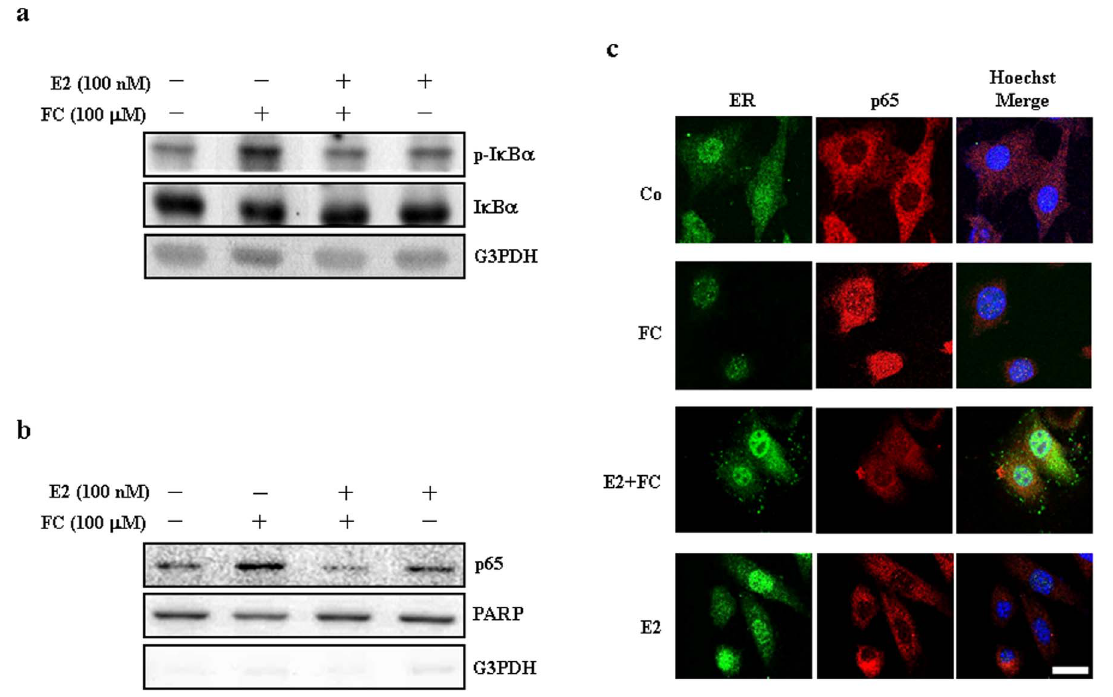
Figure 3. Effects of E2 on the FC-induced I k B a phosphorylation and nuclear translocation of NF k B in the CEC. (a) The FC-induced increases of the levels of p-I k B a in the CEC were abolished by E2 (100 nM) treatment. Membrane was probed with anti-G3PDH antibody to verify equivalent loading. (b) The FC-induced an increase of p65 nuclear translocation in the CEC was abolished by E2 (100 nM) treatment. PARP and G3PDH were used as a nuclear and cytosolic protein marker, respectively, to confirm the purities of isolation and to verify equivalent loading. (c) E2 and FC induced nuclear translocation of ER and p65, respectively. After treatment with FC for 4 h, the CEC was fixed and then labeled with an anti-p65 antibody followed by a Rhodamine-conjugated secondary antibody and an anti-ER antibody followed by a FITC-conjugated secondary antibody. The nuclei were visualized with Hoechst (1 m g/mL) staining as described in Materials and Methods. Bar =25 m m. Co, control; E2, estradiol; FC, ferrous citrate.